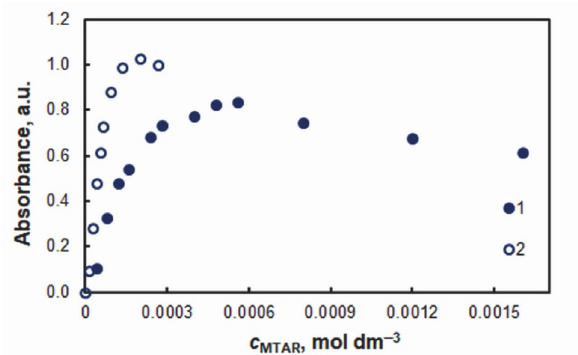
Figure 3. Absorbance vs. concentration of MTAR. (1) c Ni = 4 × 10 −5 mol dm −3 , c A366 = 1.4 × 10 −2 mol dm −3 , pH 6, V aq. phase = 5 cm 3 , ex-